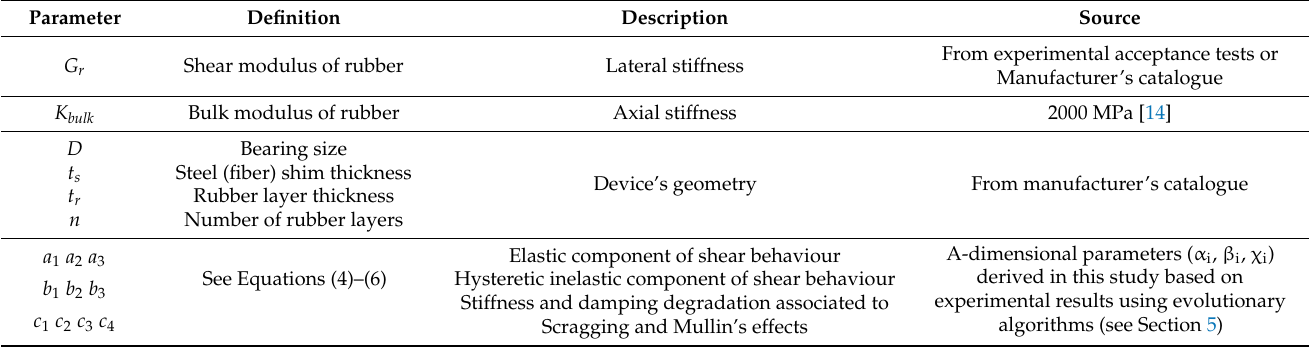
Table 2. Defining parameters of the HDR Element.